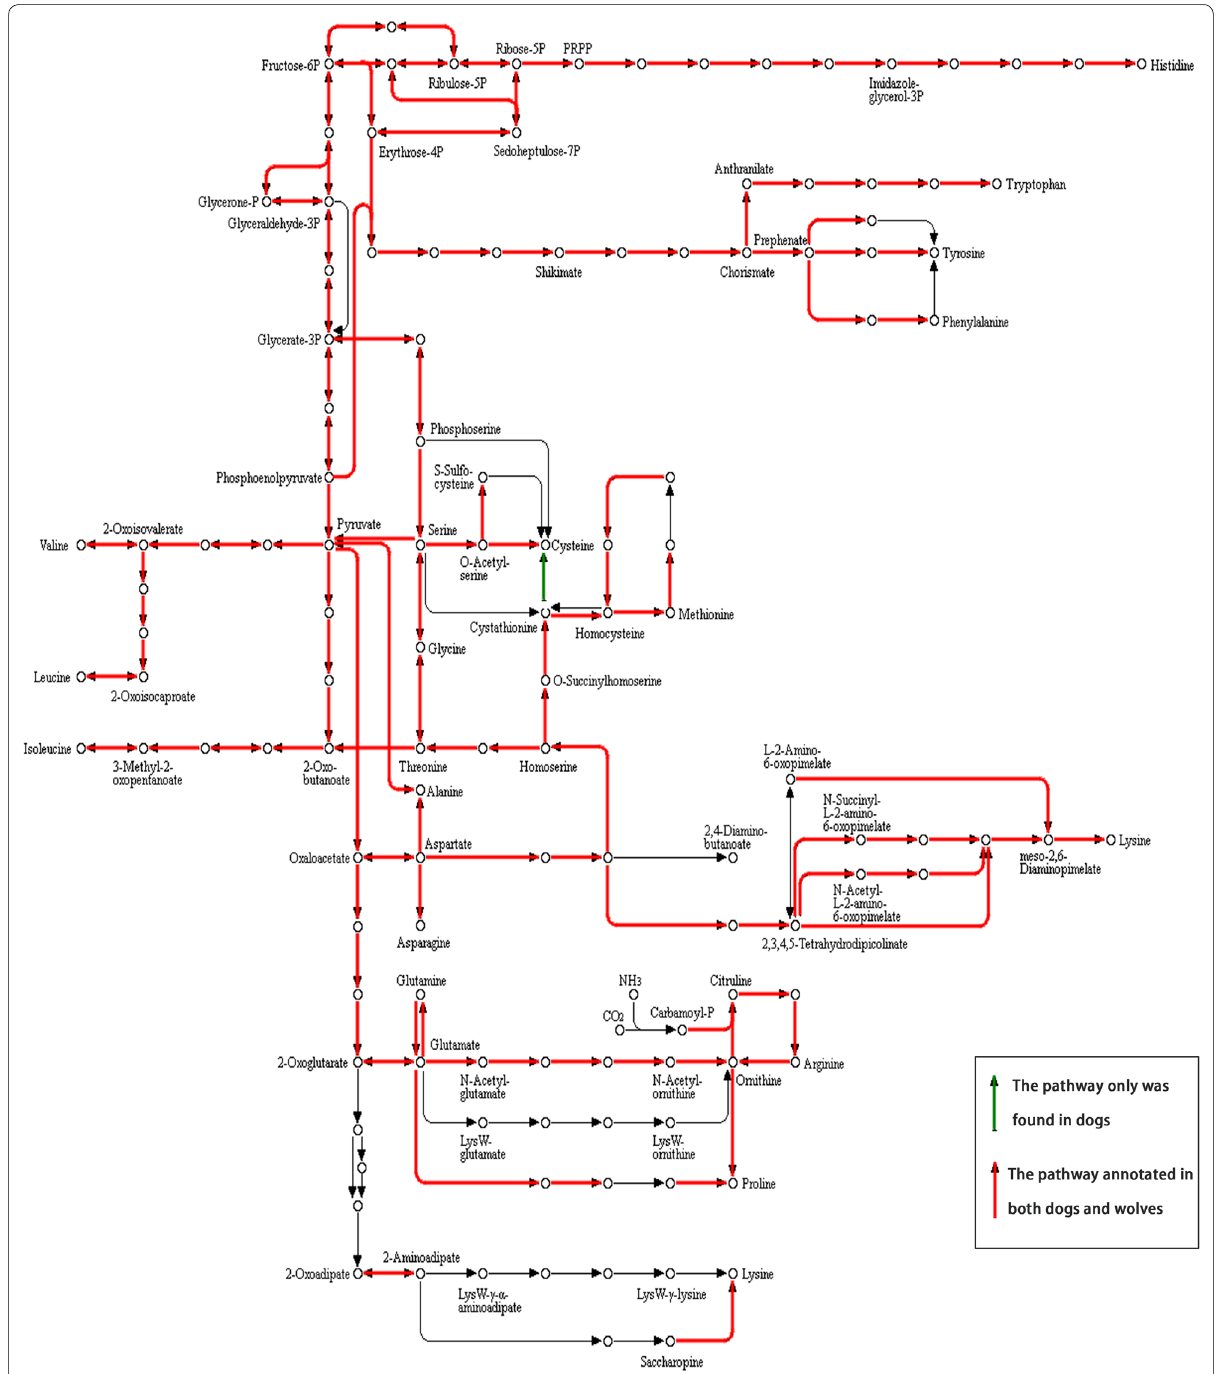
Fig. 6 The annotated pathway of amino acids